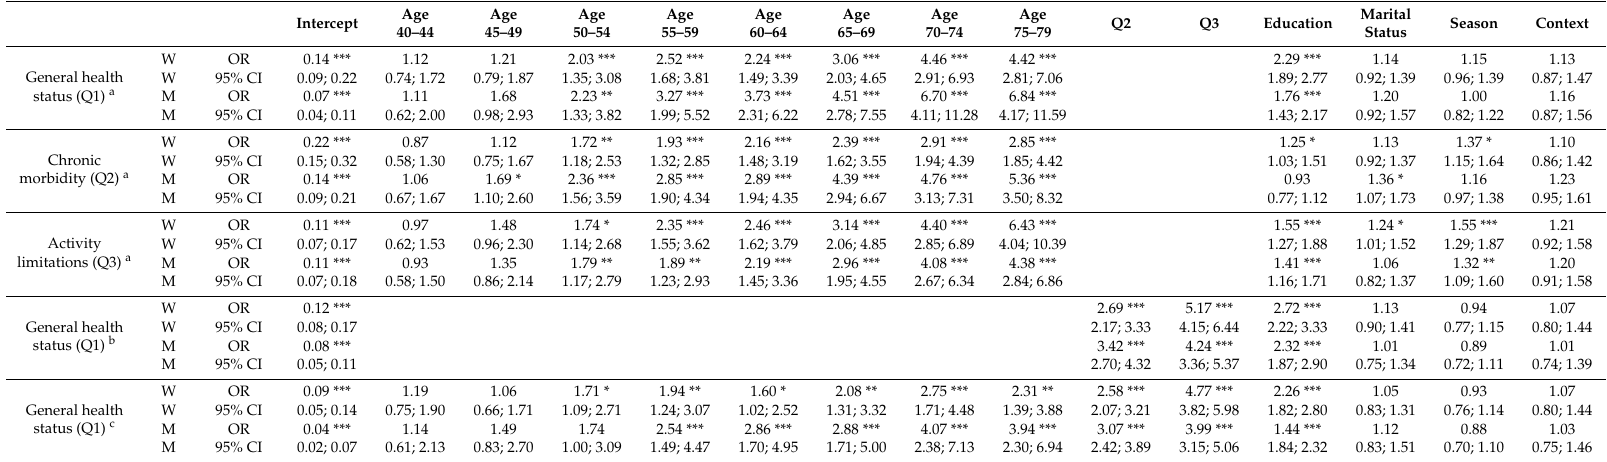
Table 1. Logistic regression models of dichotomized Minimum European Health Module (MEHM) (data source: the CUORE Project Health Examination Survey 2008–2012, Italian men and women, 35–79 years